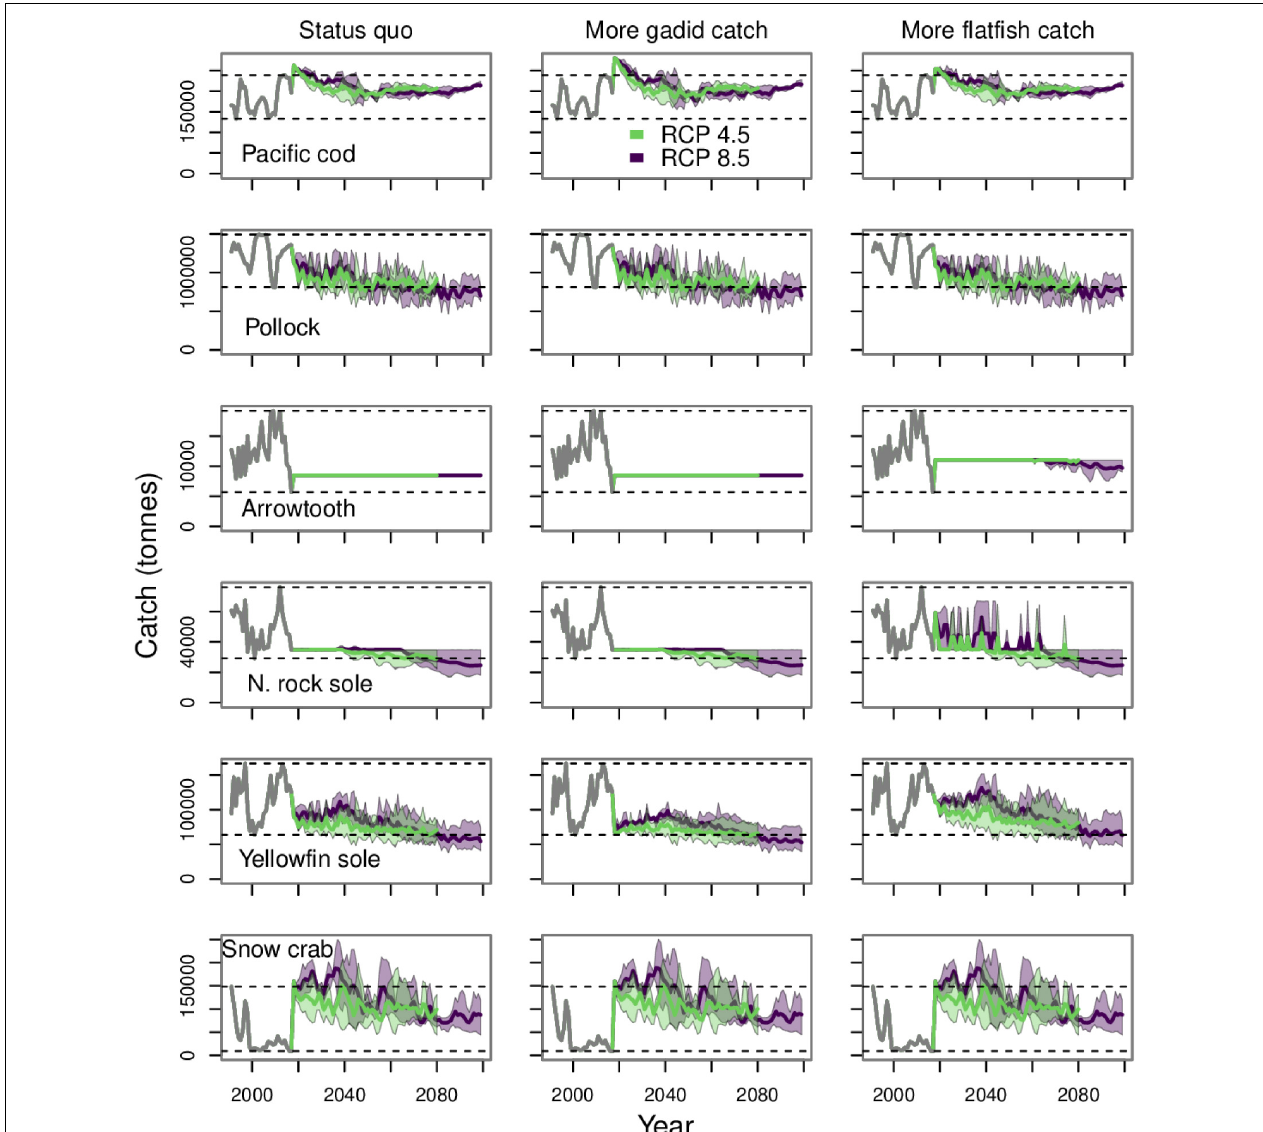
FIGURE 6 | Catch projections for the core commercial species run under the three fishing scenarios that include fisheries catch. The gray line from 1991 to 2017 indicates the observed catch during the historical period. The purple and green polygons indicate the minimum and maximum range for the three earth system models run under each RCP. The purple and green lines indicate the mean of the three runs for each RCP. The dashed lines indicate the historical minimum and maximum values.